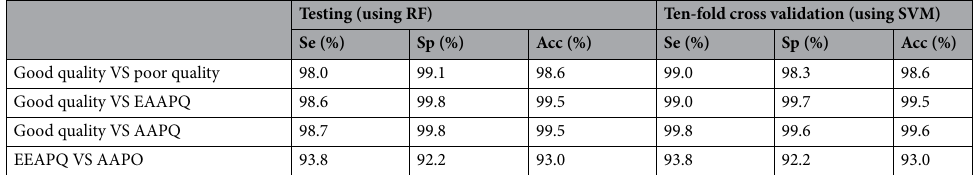
Table 5. The performance of ARIA in testing dataset. RF Random forest, SVM Support vector machine, EAAPQ Eye-abnormality-associated-poor-quality, AAPQ Artefact-associated-poor-quality, Se Sensitivity, Sp Specificity, Acc